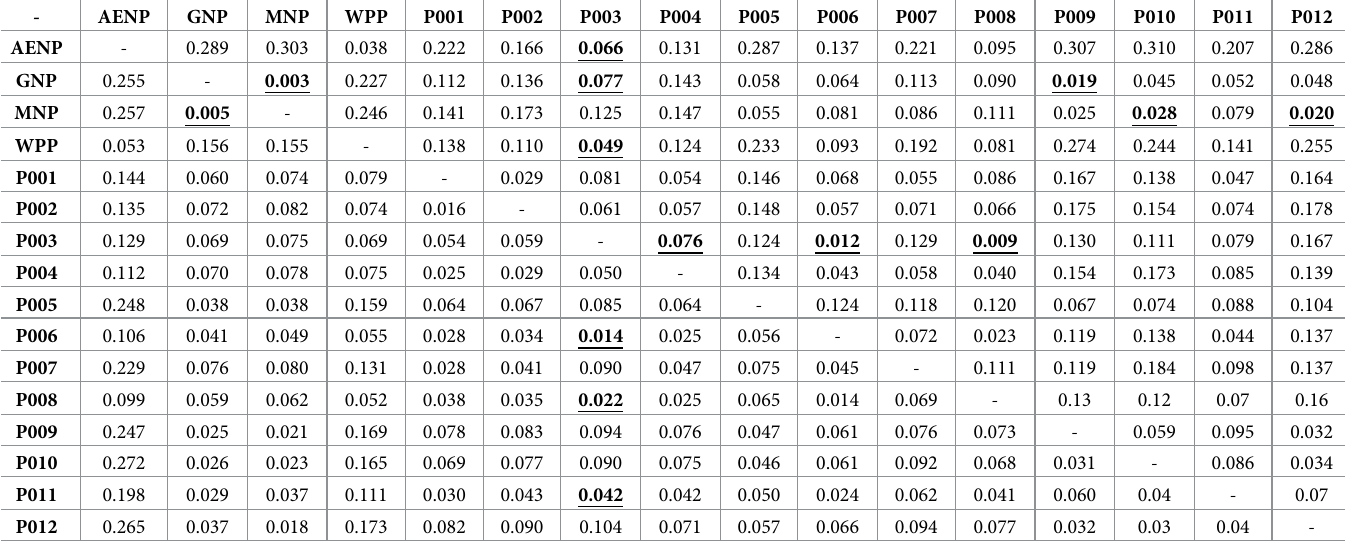
Table 2. Pairwise D JOST (above diagonal) and F ST (below diagonal) values for the 16 sampling localities in this